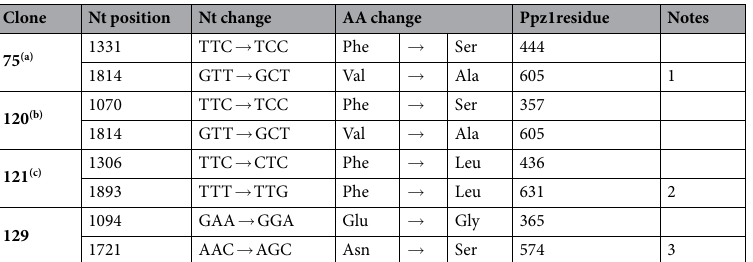
background. As deduced from Fig. 5a and b, all clones exhibited a rather strong phenotype compared with that of cells carrying the wild type phosphatase. Tolerance to caffeine was also confirmed by continuous monitoring of growth in liquid culture (Supplementary File 6). In addition, when variants 120 and 121 were introduced in the slt2 hal3 or in the ppz1 hal3 backgrounds, and the resulting strains tested, respectively, for caffeine and LiCl tolerance, these phenotypic differences were abolished (Supplementary File 3). All four variants also increased the ability of slt2 cells to flocculate (Supplementary File 4). These phenotypic effects were not due to differences in